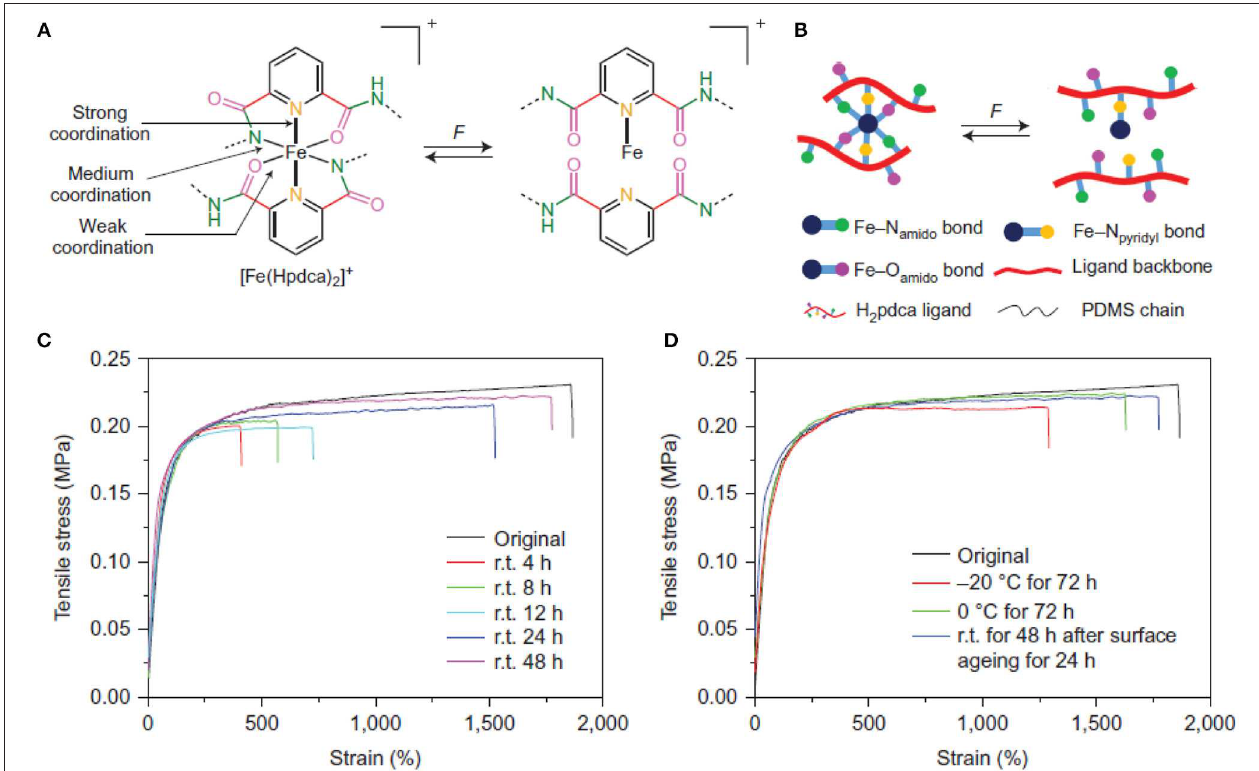
FIGURE 4 | (A,B) Schematic structure of material design and single-molecule force spectroscopy characterization. (C) Stress–strain curves of a film healed at room temperature (r.t.) for different lengths of time show an increase of the stretching ability when the film is allowed to heal for longer. (D) The stress–strain curves of the film healed at − 20 and 0 ◦ C for 72h, and the stress–strain curves of the film healed at room temperature for 48h after surface aging for 24h (Li et al., 2016a). Reproduced with the permission of 2016 American Chemical Society.